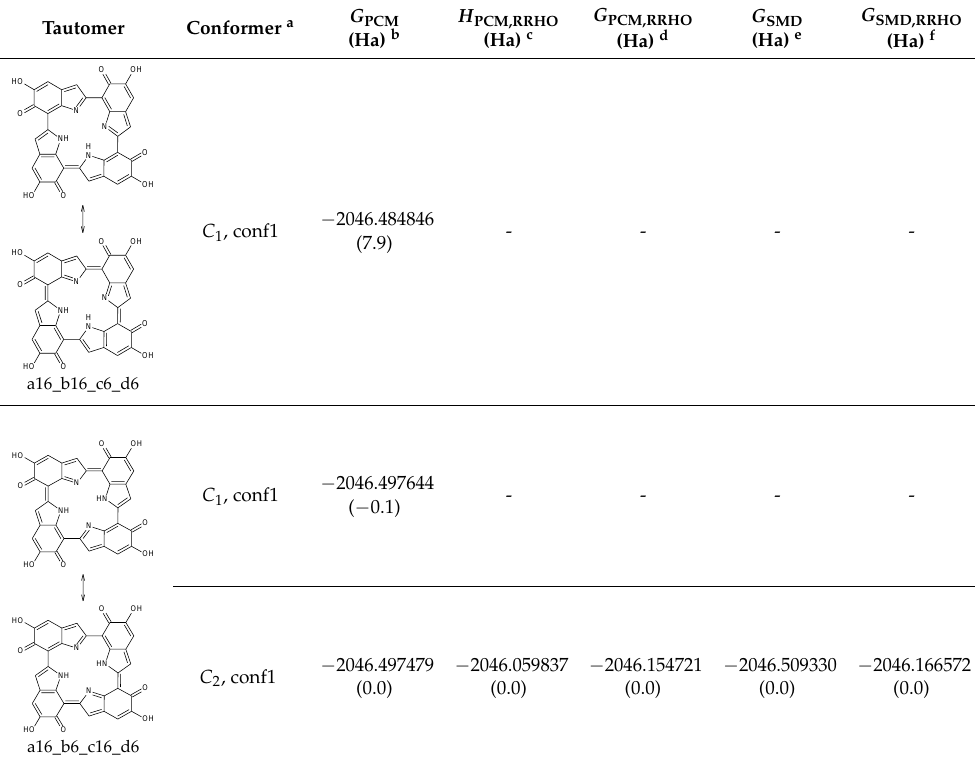
Table 13. KP-6e, neutral form in water.